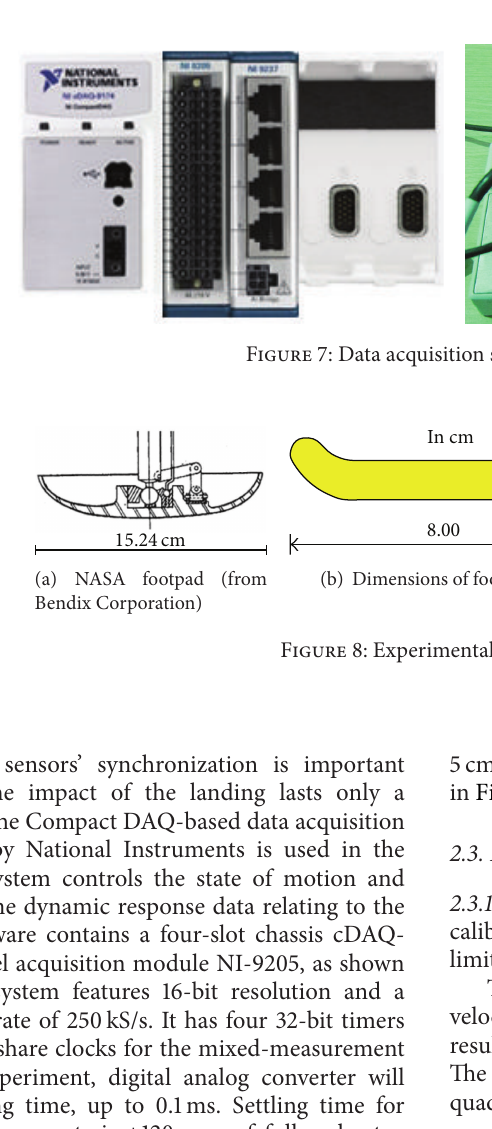
Figure 6: Transducers used in the impact test.